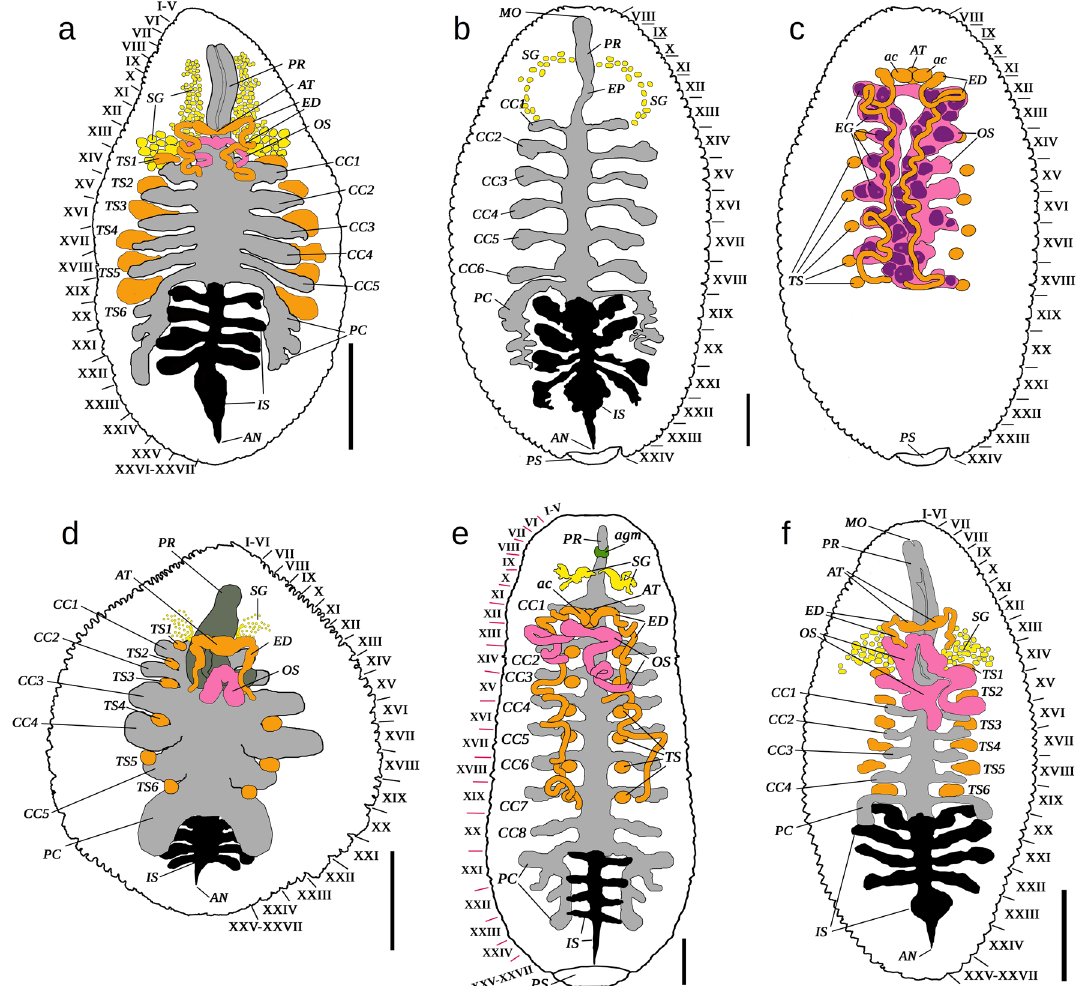
Figure 5. General scheme of the digestive and generative systems of the new taxa of the Glossiphoniidae (dorsal view; line contours of body and posterior sucker are shown). ( a ) Alboglossiphonia sibirica sp. nov. (paratype RMBH Hir_0013, Yakutia Republic). ( b , c ) Glossiphonia arctica sp. nov. (paratype RMBH Hir_0457, Polar Urals): digestive ( b ) and generative ( c ) systems. ( d ) G. taymyrensis sp. nov. (paratype RMBH Hir_0256_1, Taymyr Peninsula). ( e ) Hyperboreomyzon polaris gen. & sp. nov. (paratype RMBH Hir_0216, Kolguev Island). ( f ) Helobdella okhotica sp. nov. (paratype RMBH Hir_0491_1, Kamchatka Peninsula). MO mouth, PR proboscis sheath, EP esophagus, SG salivary glands, CC pairs of crop caeca with their numbers, PC the last pair of crop caeca (posterior caeca), IS intestine, AN anus, AT atrium, ac atrial cornua, ED ejaculatory ducts, TS testisacs with their numbers, OS ovisacs, EG eggs, PS posterior sucker, agm anterior ganglionic mass. Body somites are indicated by roman numerals. Scale bars = 1.0 mm ( a – d , f ) and 2.0 mm ( e ). Graphics: Ivan N.